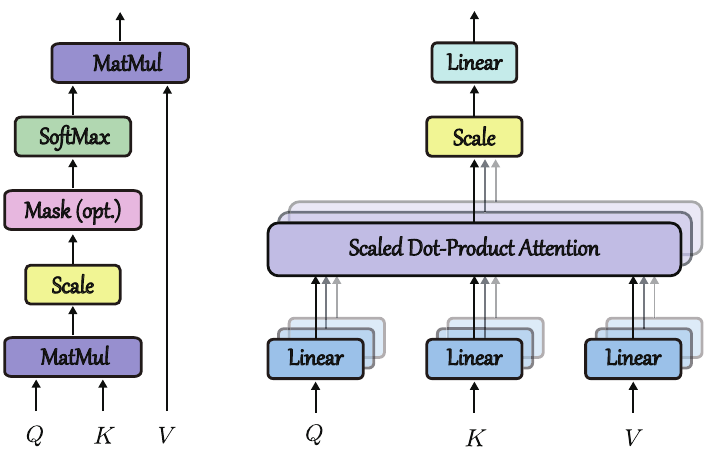
Figure 3. Architecture of attention mechanism. ( Left ) Self-attention. ( Right ) Multi-head self- attention